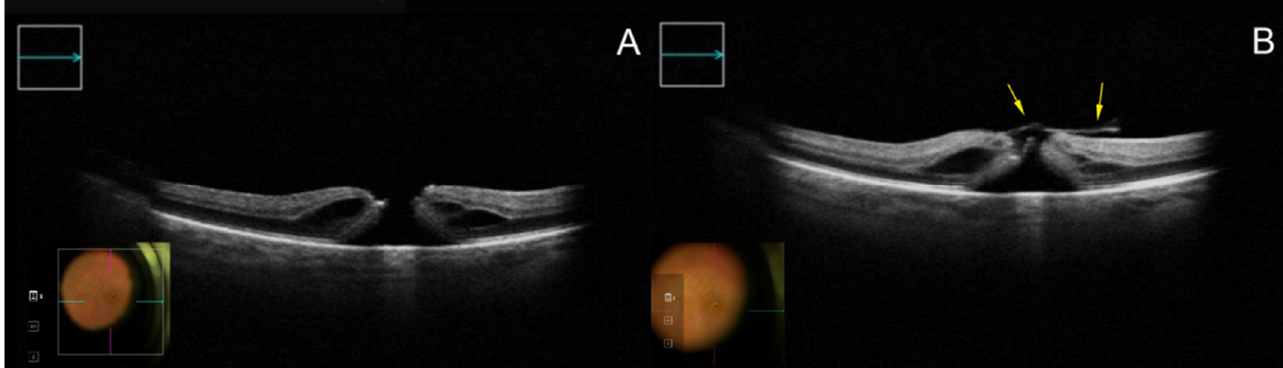
Figure 1. Appearance of an FTMH on iOCT before ( A ) and after ( B ) preparation of the temporal inverted ILM flap (yellow arrows) viewed through a horizontal cross-section (green arrow). Abbre- viations: FTMH, full-thickness macular hole; iOCT, intraoperative optical coherence tomography; ILM, internal limiting membrane.